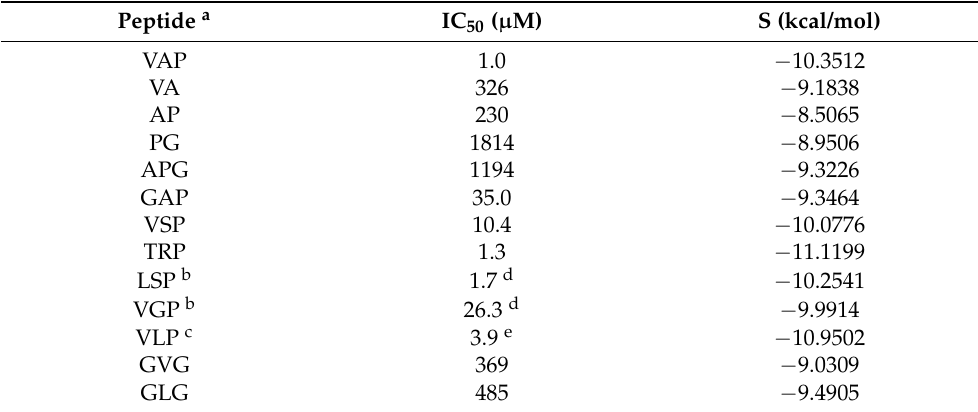
Table 2. IC 50 and docking score S values of ACE inhibitory peptides.